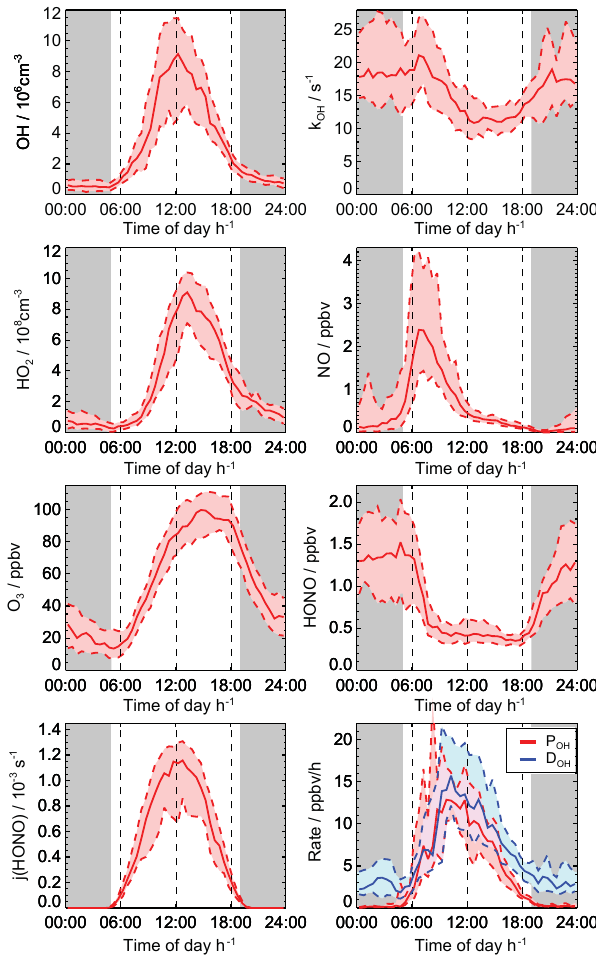
Figure 8. Median diurnal profiles of trace gas concentrations used for the calculation of the total OH production rate ( P OH ) and de- struction rate ( D OH ). Data are only included if all required trace gas concentrations and OH reactivity were measured concurrently. Colored areas give 25 and 75 percentiles. Gray areas indicate night- time. Note that the selection of data are different for median profiles shown in our accompanying paper by Tan et al. (2017).